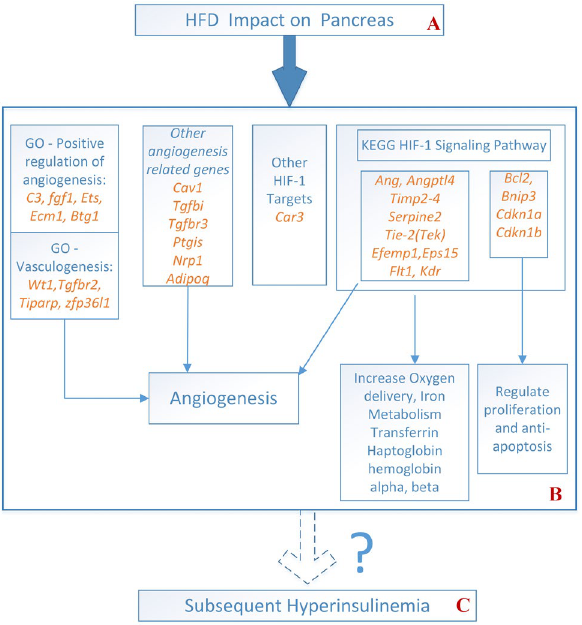
Figure 6. A number of genes including those downstream of HIF-1 signaling pathway were up-regulated in the pancreas in response to HFD. The sorted loadings of pancreatic HFD gene eigenvector demonstrated that the exposure to HFD ( A ) upregulated the genes downstream of the KEGG HIF-1 signaling pathway ( B ) Most of these genes are related to increasing oxygen delivery including angiogenesis whereas some others are related to regulation of proliferation and anti-apoptosis. Genes related to angiogenesis other than those in the KEGG HIF-1 signaling pathway such as Ang were also examined, including Adipoq , Cav1 and Ptgis , and others from the Biological Processes of Gene Ontology (GO): Positive Regulation of Angiogenesis and Vasculogenesis. The top ranked gene Car3 in the HFD gene eigenvector was reported to be a target of HIF-1signaling pathway 17 . ( C ) Whether this kind of up-regulation attributed, at least in part, to the subsequent over-secretion of insulin from the pancreas that results in hyperinsulinemia is worth of future